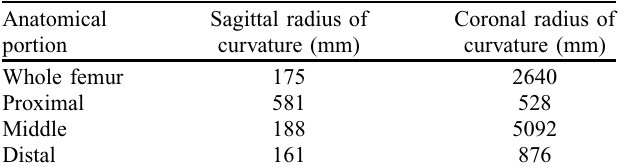
Table 1. Summarizes our measurements of radii of curvature in sagittal and coronal planes of Japanese femora in proximal, middle, and distal portions as well as the whole femoral